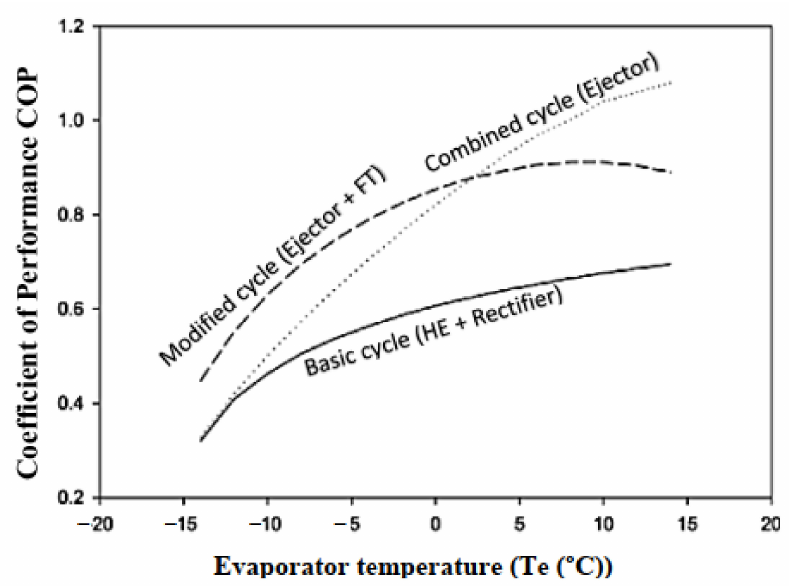
Figure 7. Effect of evaporator temperature on the COP for different cycle configurations